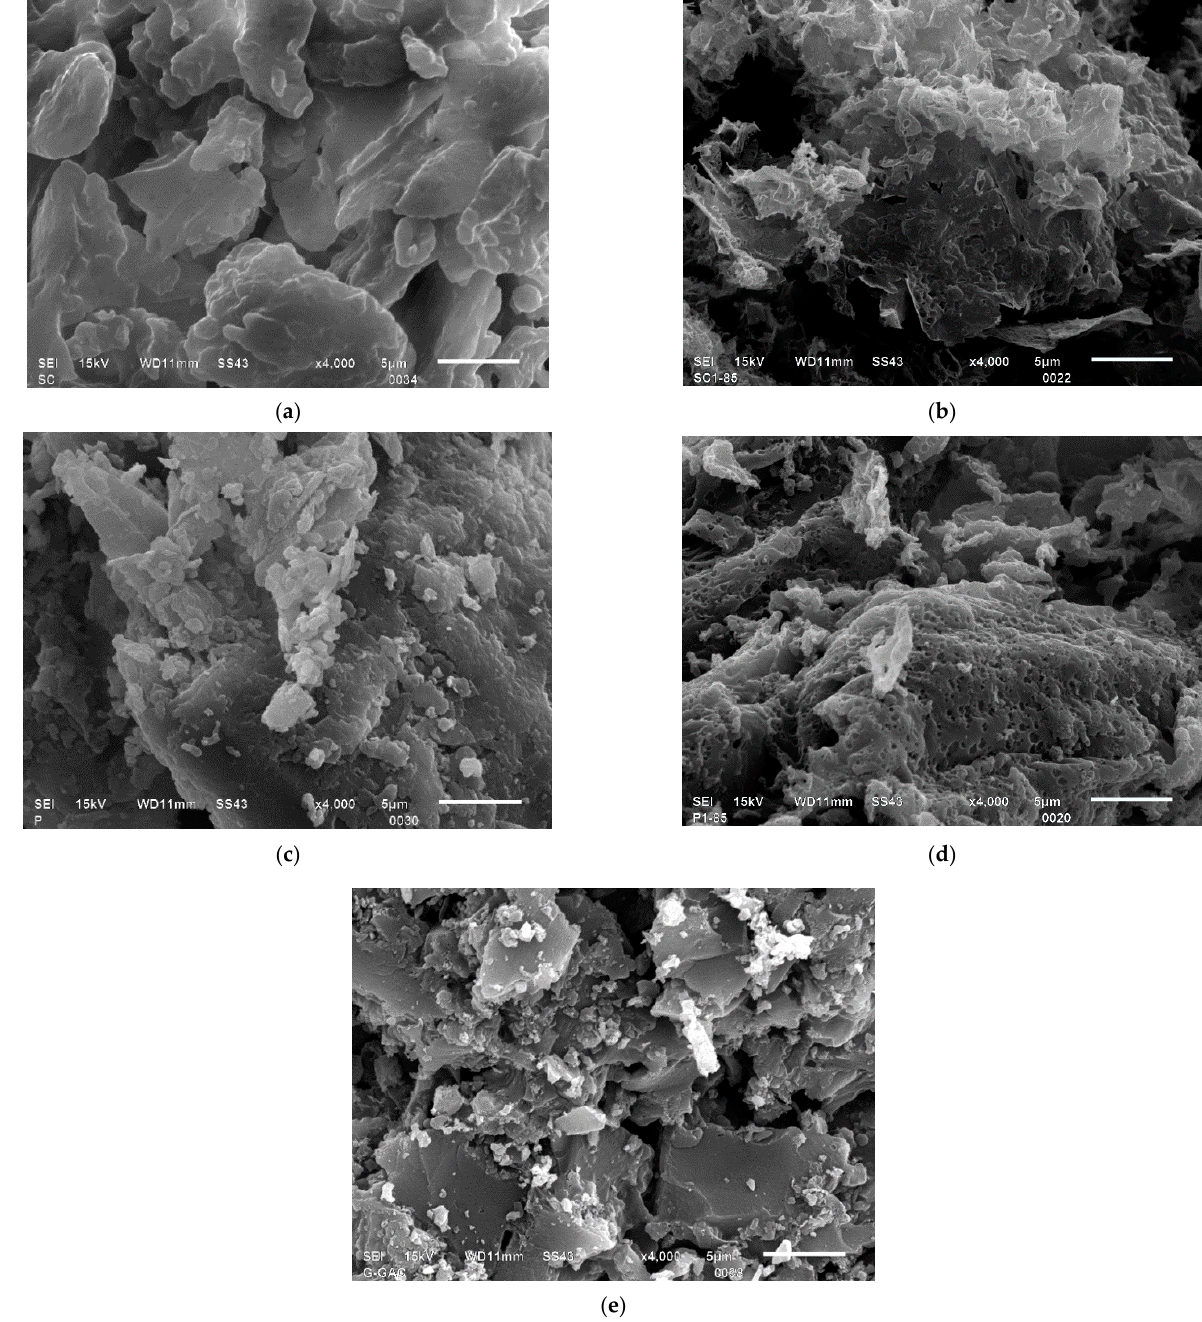
Figure 1. Scanning electron microscope (SEM) images of activated carbon produced from ( a ) raw spent coffee grounds, ( b ) spent coffee grounds, ( c ) raw coffee parchment, ( d ) parchment, and ( e ) commercial activated carbon.